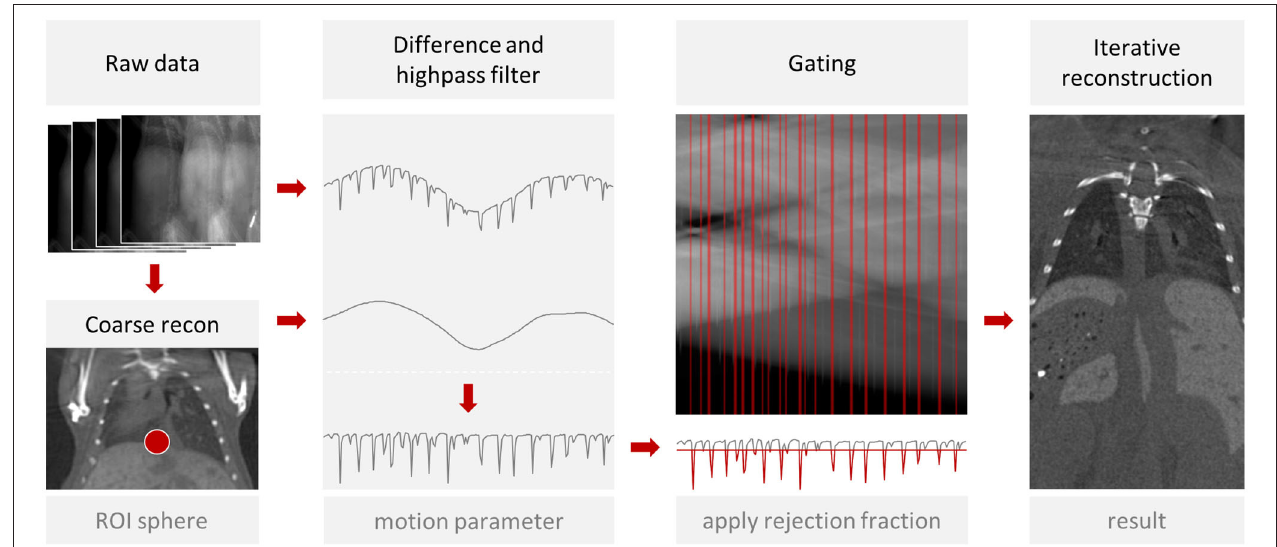
FIGURE 3 | Gated reconstruction approach. A coarse preview is reconstructed from the raw data and the user can mark the diaphragm with a sphere (ROI). From the signal intensity inside the projected sphere, the algorithm computes a motion score for each projection and rejects a fraction of the projections. From the remaining projections, a reconstruction is computed. This process is repeated for each mouse of a multi-mouse scan.